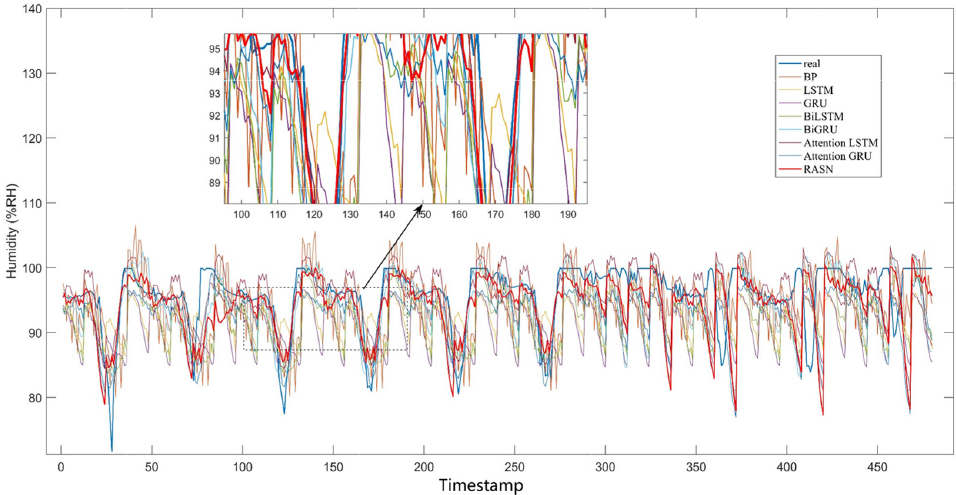
Figure 9. Comparison of model predictions based on humidity data.